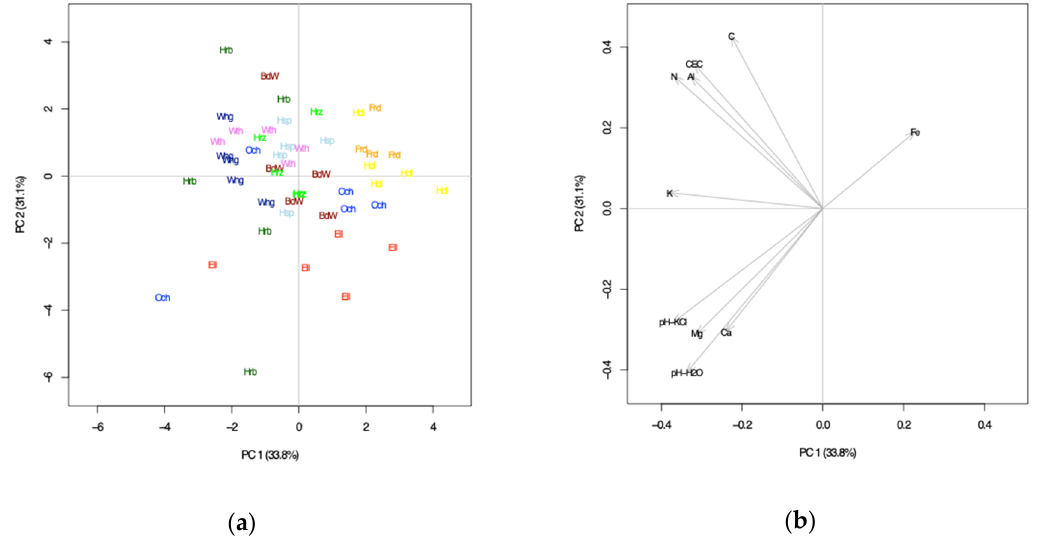
Figure 1. Principal component analysis (PCA) to characterize study site grouping parameters: ( a ) study sites and ( b ) principal